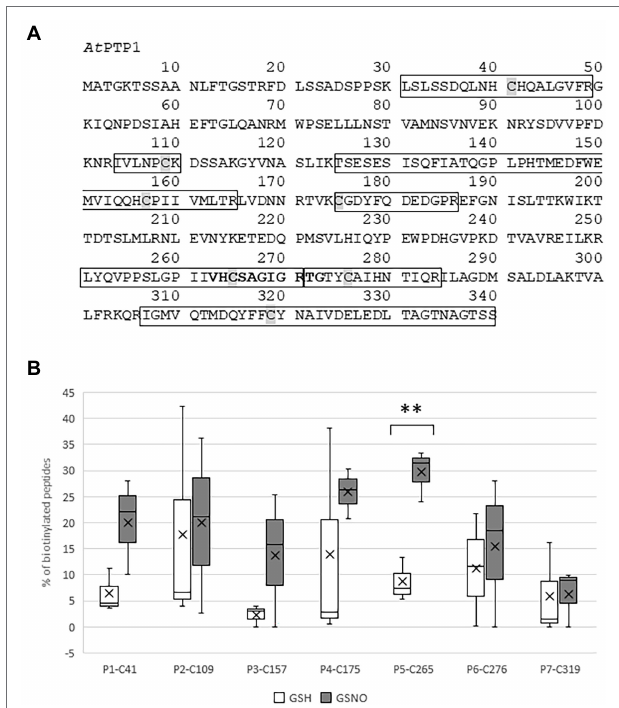
FIGURE 2 | Identification by mass spectrometry of the Cys residues of histidine (His)- At PTP1 targeted by S-nitrosation. (A) Primary sequence of At PTP1 protein. The seven peptides identified by mass spectrometry are boxed, the Cys residues are shaded and the active site signature motif of PTPases is indicated in bold. (B) Relative percentage of biotinylated peptide to the total abundance of this peptide in the sample following treatment of His- At PTP1 by 100 μ M glutathione (GSH) or S-nitrosoglutathione (GSNO). Values are the results of three mass spectrometry analyses. Significant difference is denoted by an asterisk: ** p ≤